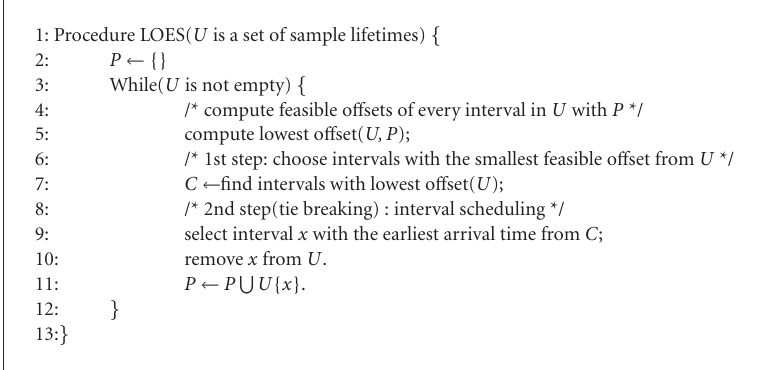
Figure 13: Pseudocode of LOES